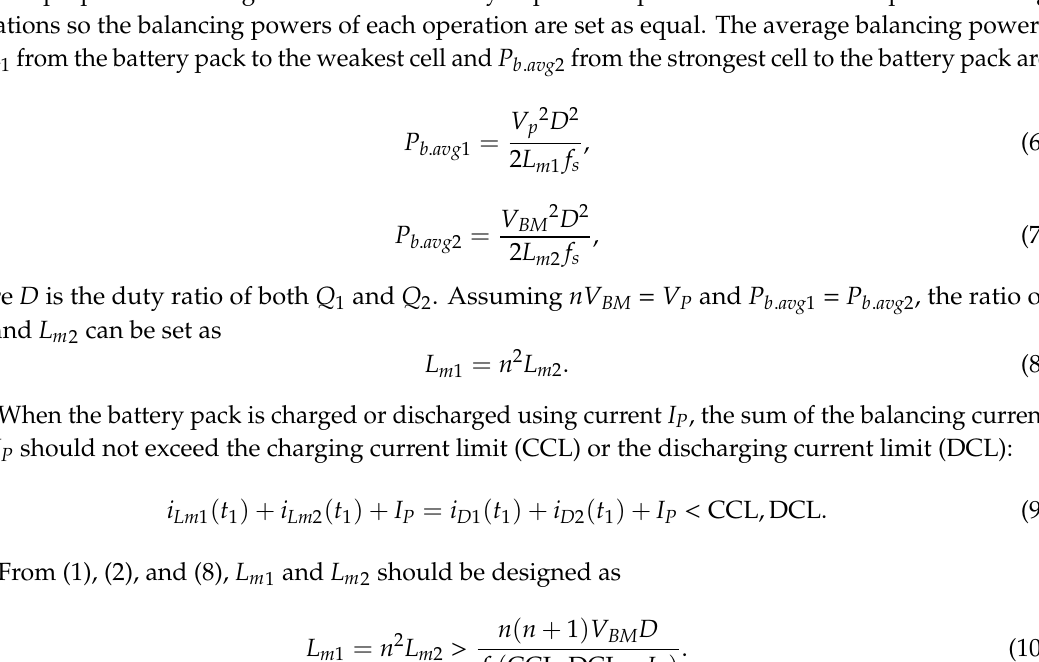
Figure 6. Balancing algorithm for the proposed balancing circuit.